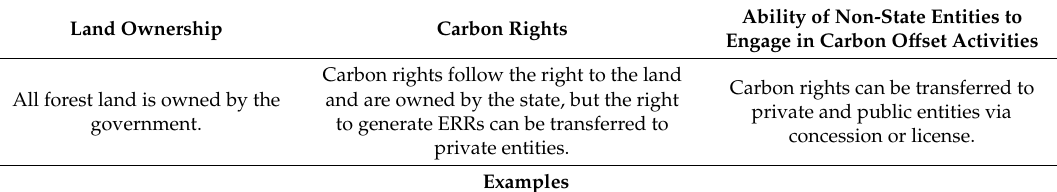
Table 2. Overview of carbon rights